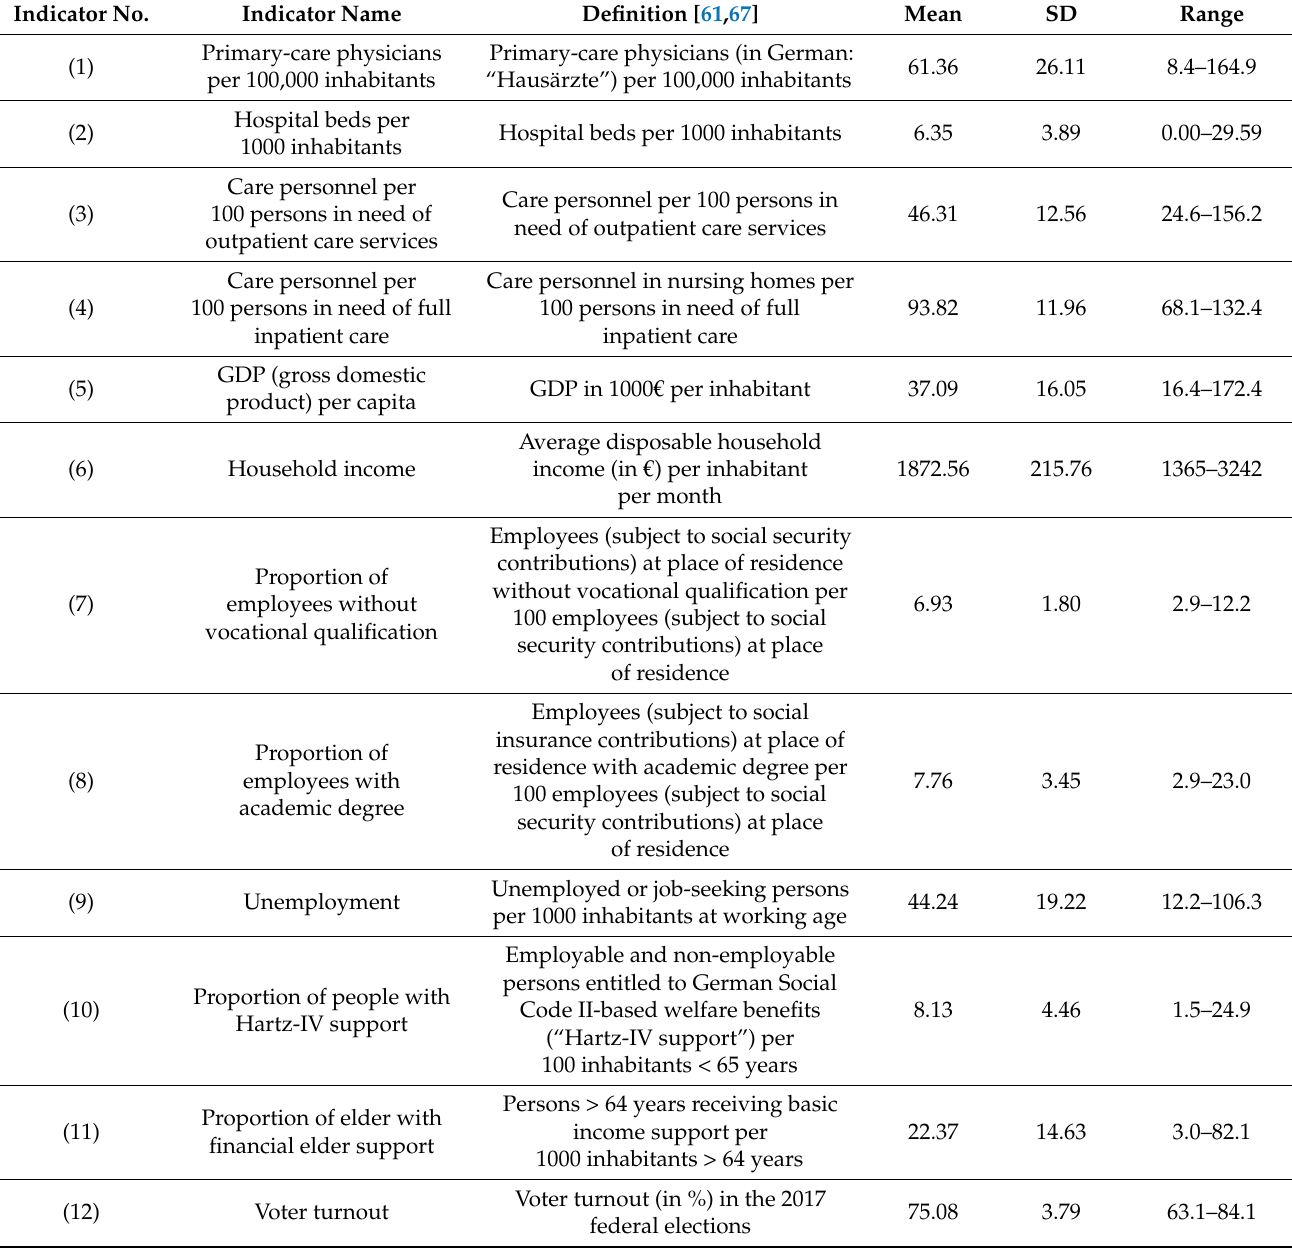
Table 1. Description of district-level indicators * investigated as potential predictors in the regression analyses: definitions, means, standard deviations (SD) and ranges; N = 401 German districts. Indicator